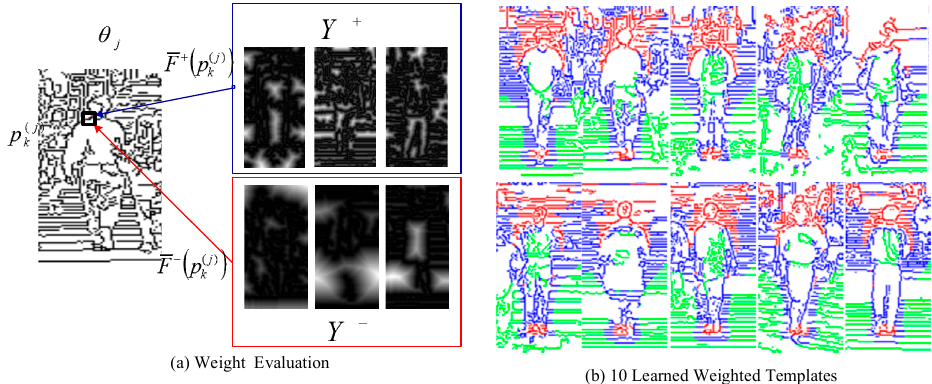
Figure 2. ( a ) Schematic description for weight evaluation; ( b ) is the learned 10 templates using the expectation maximization (EM) algorithm. Red, blue, and green points are with high-weight, middle-weight and low-weight, respectively.